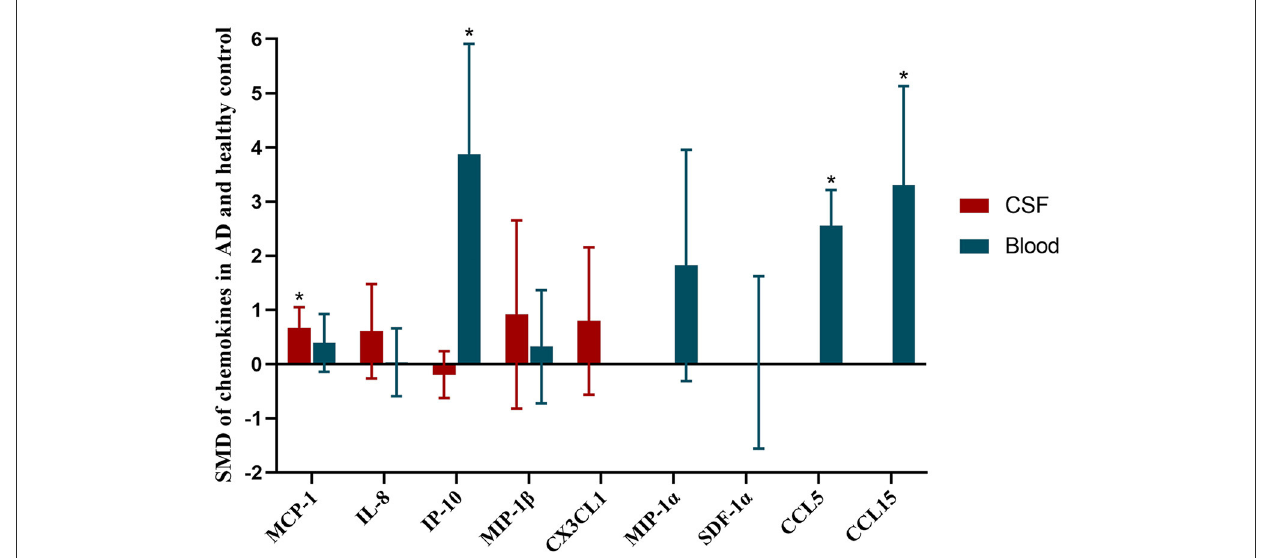
FIGURE4 SMD of chemokines in AD and healthy control. Asterisks indicate significant significance between groups. Red histogram shows SMD between AD and healthy controls in CSF samples. Blue histogram shows SMD between AD and healthy controls in blood